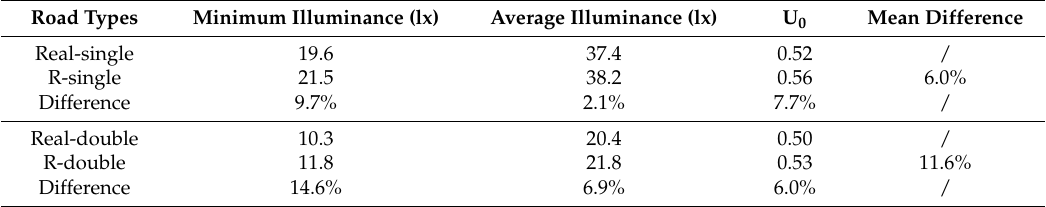
Figure 11. Illuminance reconstructions of real road light scenes. ( a ) The real single road lighting, 27 m in length and 7 m in width. The measured points are 10 × 6. ( b ) The real double road lighting, 32 m in length and 20 m in width, and a half is measured. The measured points are 33 × 9. Table 2. Illuminance parameters of simulated and reconstructed road lightings. The ‘Real’ represents real road lighting, and ‘R’ represents reconstructed road lightings.